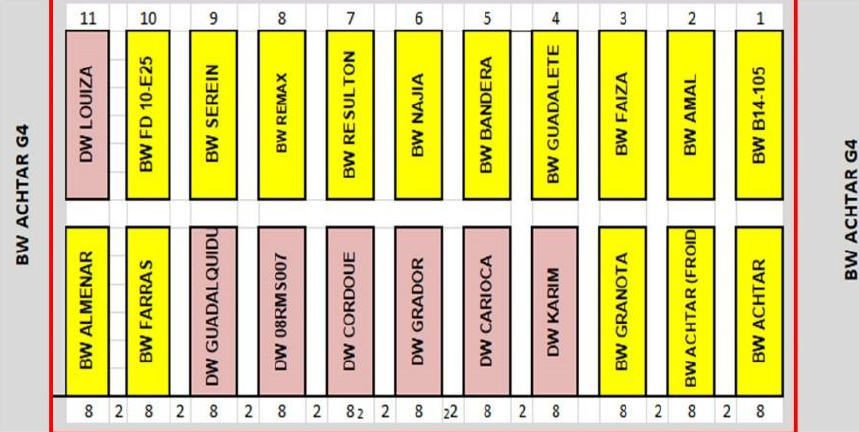
Figure 3. Experimental platform 07 (DW: durum wheat — BW: bread wheat).